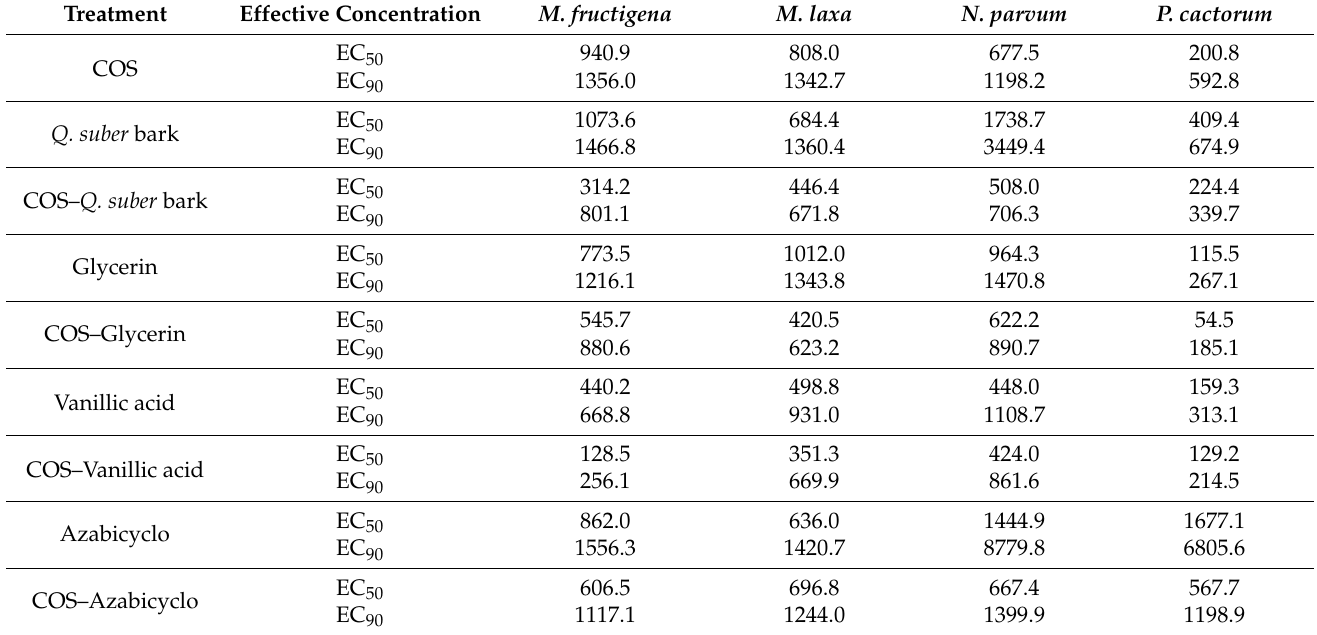
Table 1. Effective concentrations (expressed in µ g · mL − 1 ) against M. fructigena , M. laxa , N. parvum, and P. cactorum of chitosan oligomers (COS), the aqueous ammonia extract of Q. suber bark, and three of its main constituents, alone and upon conjugation with COS.